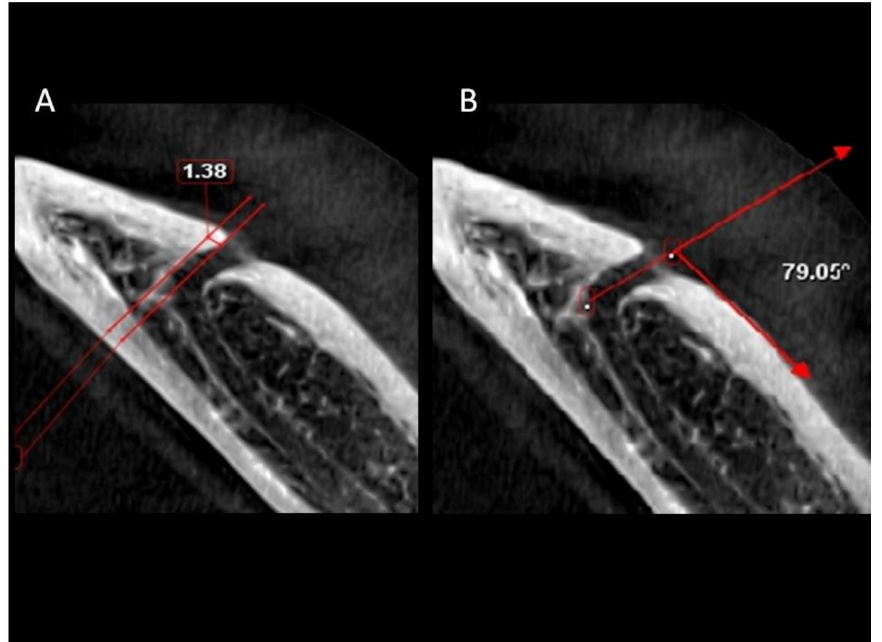
Figure 3. Axial view showing the mesial extension ( A ) and angulation between the mental canal and the buccal cortical bone posterior to the mental foramen ( B